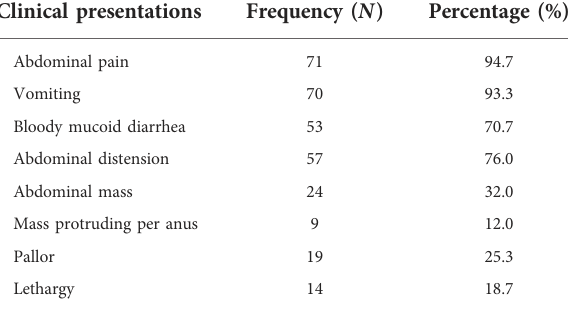
TABLE 2 Distribution of clinical presentations among children admitted and managed for acute intussusception at HFSUH, Eastern Ethiopia, 2021 ( n